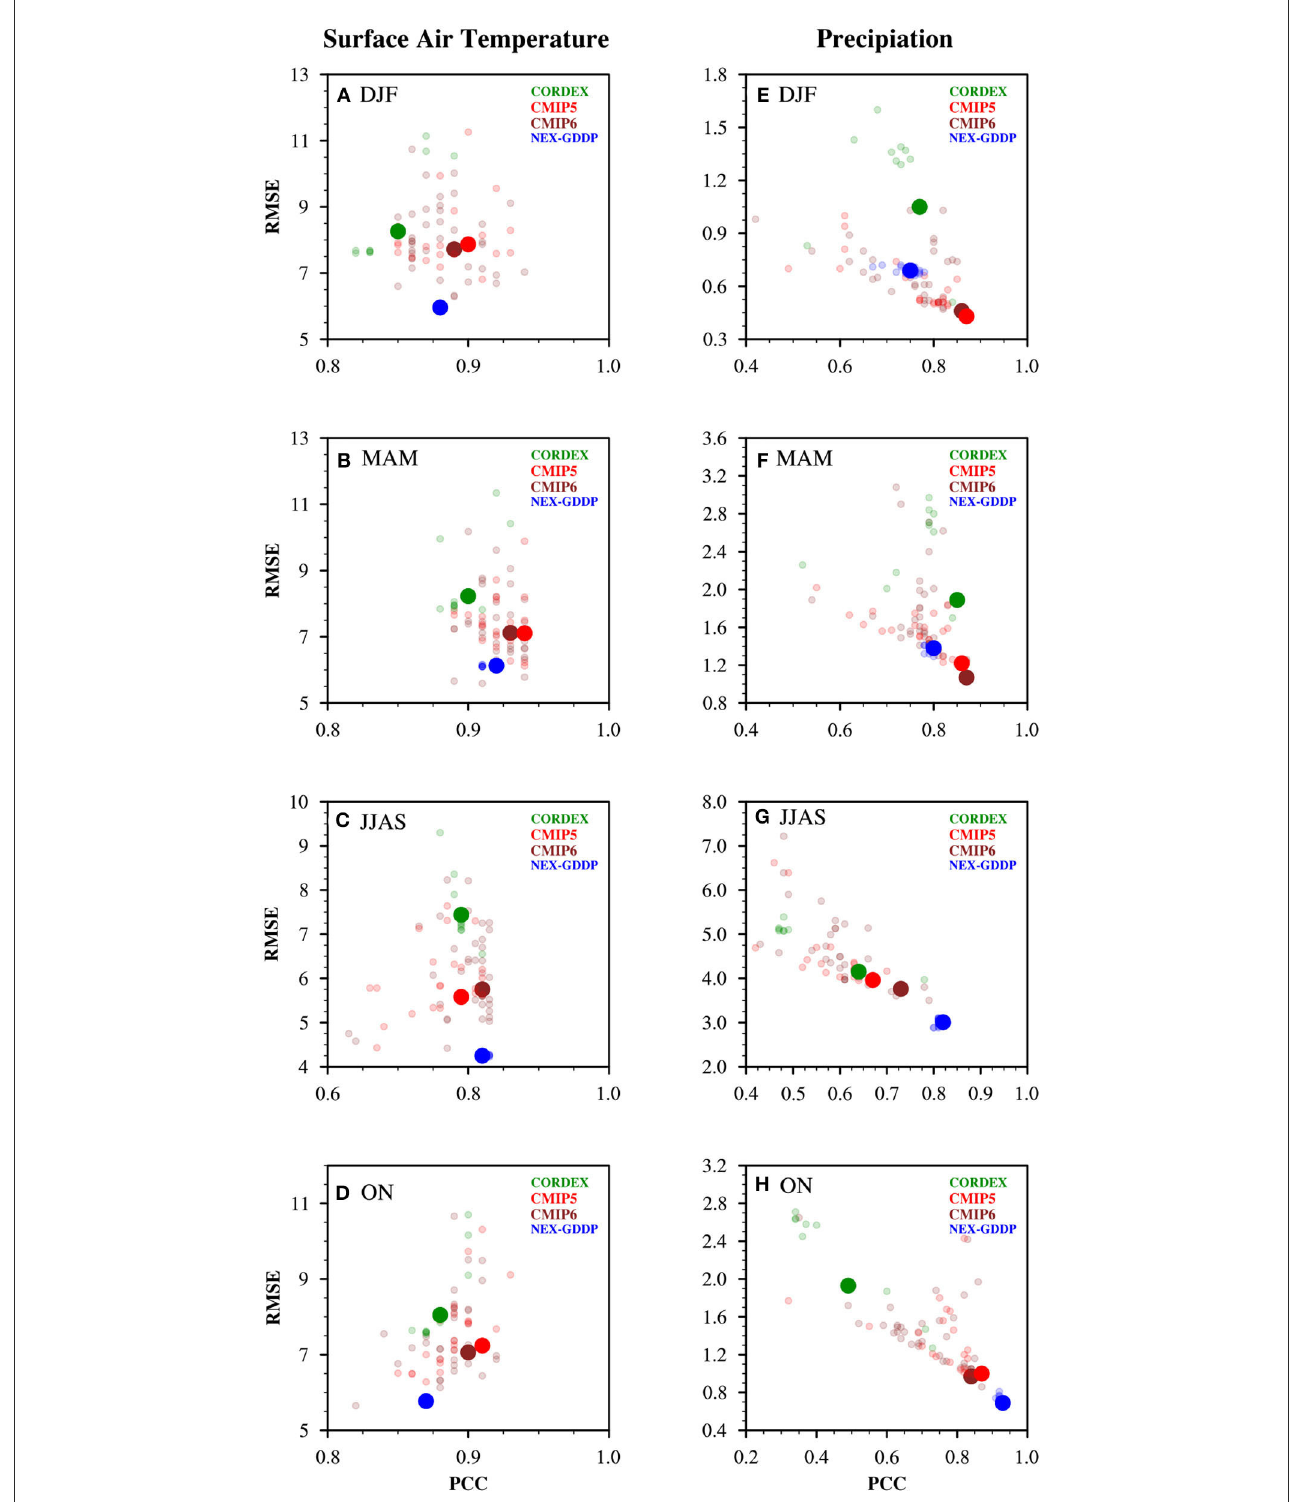
FIGURE1 Root mean square error (RMSE) and pattern correlation coefficient (PCC) values of area-averaged mean surface air temperature (A–D) and precipitation (E–G) with respect to IMD observations for the period 1975–2005 over India for DJF (A, E) , MAM (B, F) , JJAS (C, G) , and ON (D, H) . The green, red, brown, and blue colors represent the CORDEX, CMIP5, CMIP6, and NEX-GDDP models, respectively. Smaller dots represent individual models and the larger dots represent